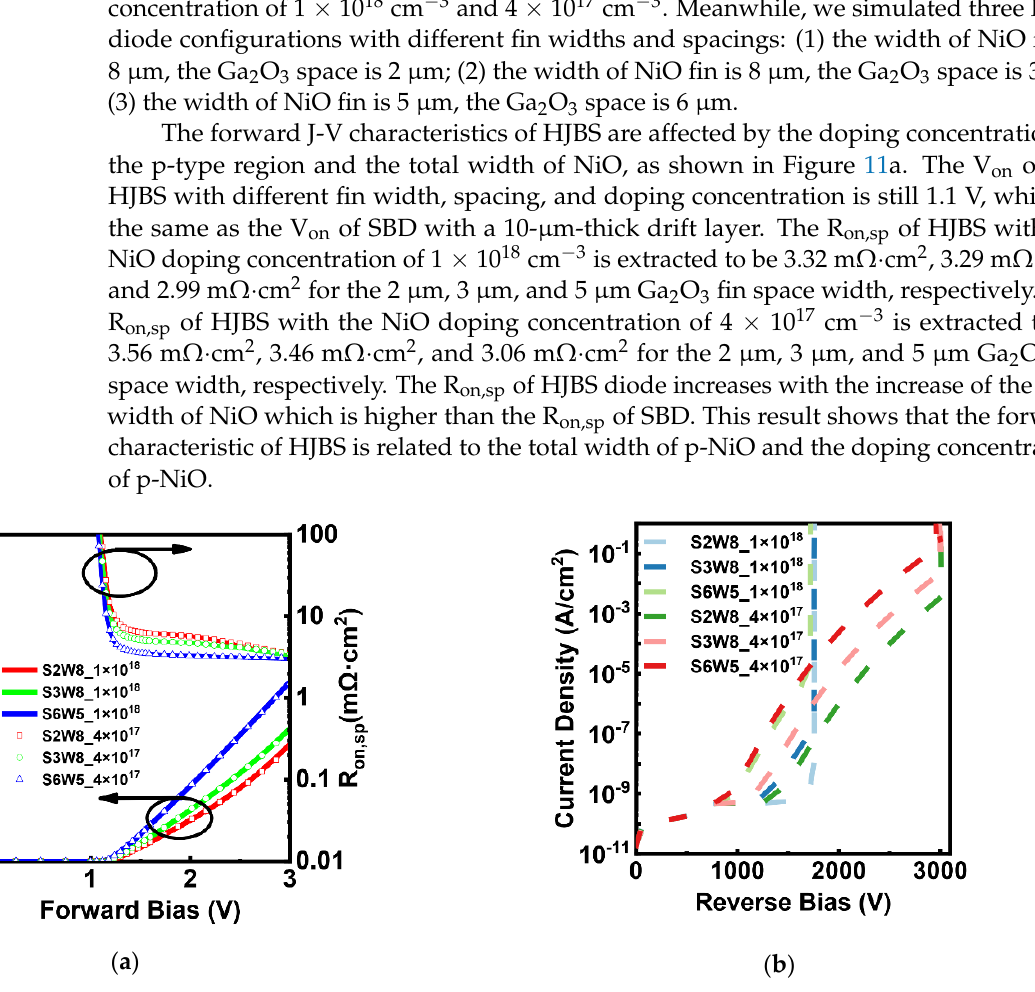
Figure 11. ( a ) Forward J ‐ V characteristics and R on,sp vs. forward bias ( b ) reverse J ‐ V characteristics of the p ‐ NiO/Ga 2 O 3 HJBS with different width, space, and doping concentration of p ‐ NiO, when the thickness of drift layer is 10 μ m.